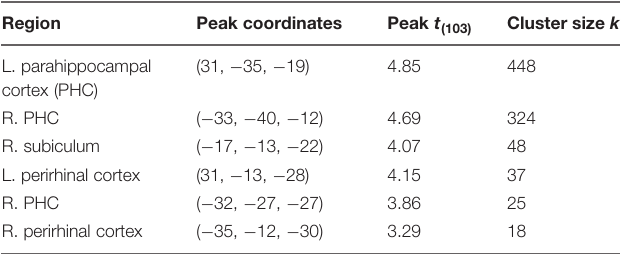
TABLE 1 | Anatomical summary of results from decay model of ongoing encoding. Region Peak